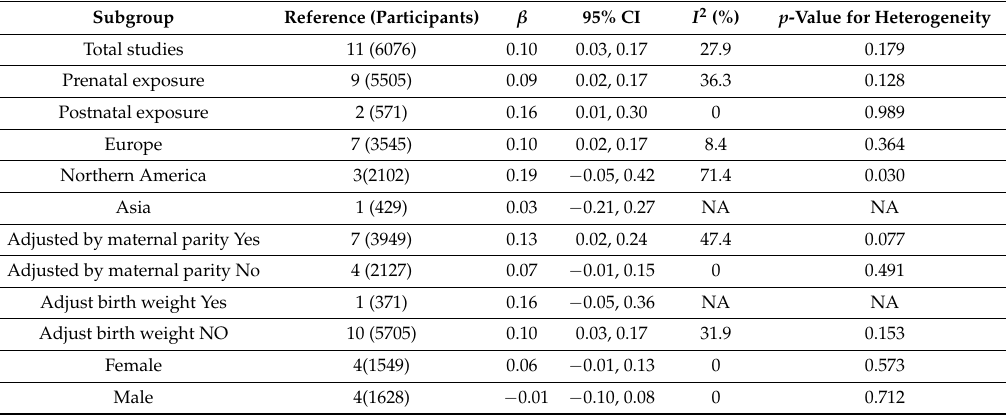
Table 2. Meta-Analysis of the Association between Exposure to Perfluorooctanoic Acid (PFOA) in Early Life and Childhood Body Mass Index